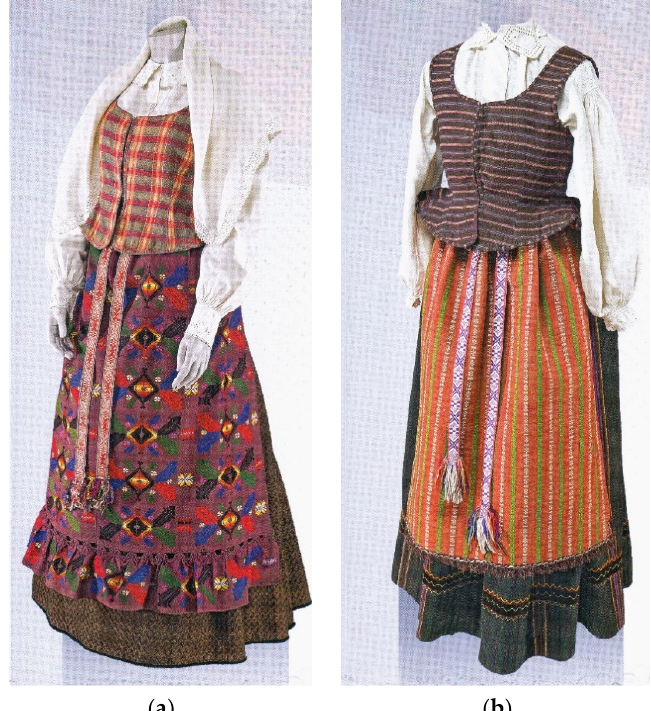
Figure 19. Folk costumes from Suvalkija: ( a ) From Šakiai district, the second half of the 19th century: Skirt LDM LA-1743; shirt LDM LA-4845; apron LDM LA-1792; vest A. and A Tamošaitis gallery, Nr. 833; sash LDM LA-1717; kerchief LDM LA-2768; ( b ) From the Kaunas and Prienai districts, the second half of the 19th century: Skirt ČDM E-1482; shirt LDM LA-3951; apron LDM LA-2115; vest ČDM E-1661; sash LDM LD-111.